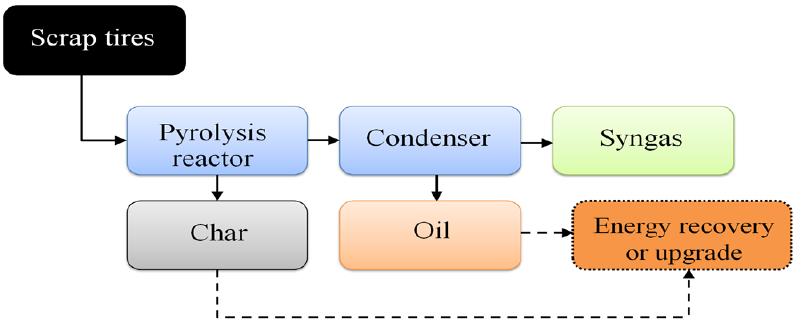
Figure 1. Products of the tire pyrolysis process.